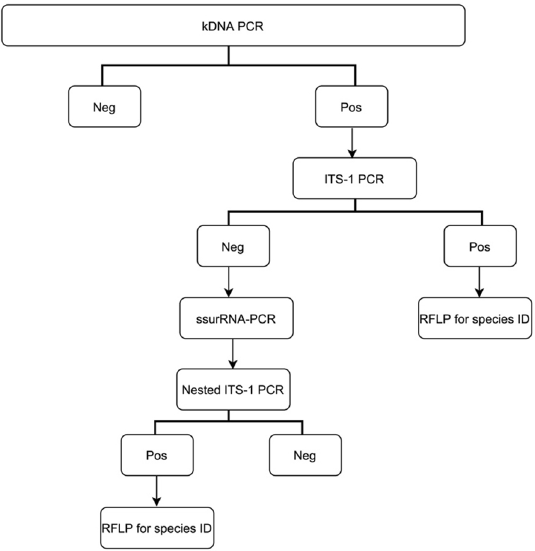
Figure 1. PCR-based Protocol for identification and speciation of Leishmania (Modified from Schönian et al., 2003 and El-Beshbishy et al., 2013) 29,32 .